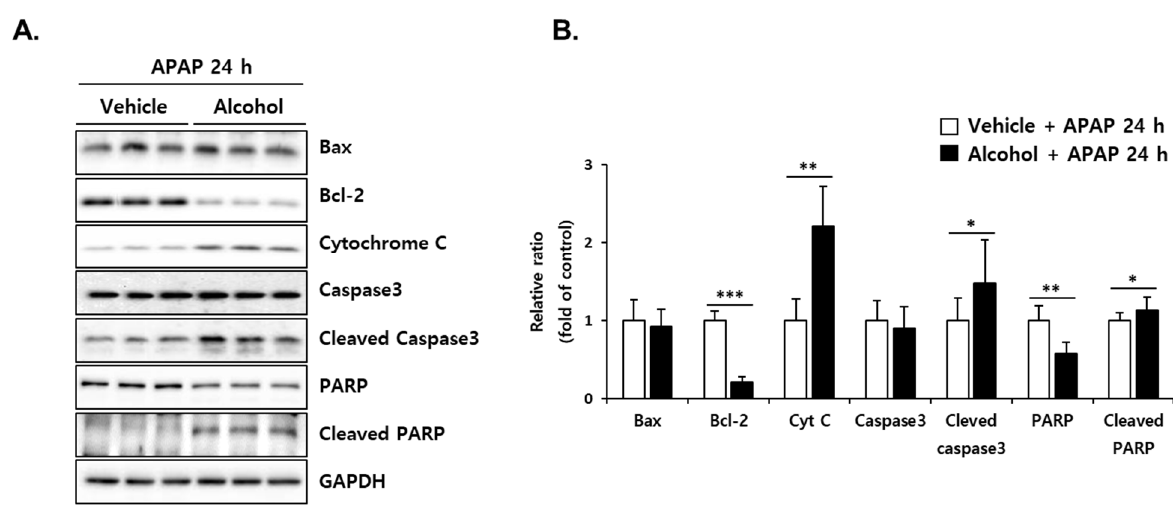
Figure 8. Alcohol binges enhanced ER stress-mediated apoptosis. Three consecutive doses of alcohol (5 g/kg, n = 5) or vehicle ( n = 5) were administered orally to mice at 12 h intervals. Twelve hours later, following the last alcohol dose, APAP (300 mg/kg) was administered orally to mice. The mice were euthanized 24 h after APAP administration (APAP 24 h). ( A ) Immunoblot analysis showing the protein levels of Bax, Bcl-2, Cytochrome C, caspase3, Cleaved Caspase3, PARP, and Cleaved PARP in mice liver tissues at APAP 24 h. GAPDH was used as the loading control. ( B ) The expression levels of proteins were normalized to that of GAPDH. *, **, *** Significantly different from the vehicle + APAP 24 h group (Student’s t test, p < 0.05, p < 0.01 and p < 0.001, respectively).